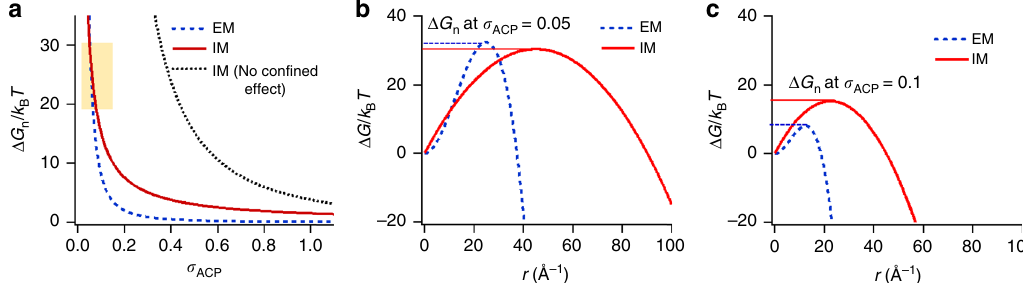
Fig. 4 Energy barriers to ACP nucleation at different σ ACP . a Δ G n for three different nucleation models: uncon fi ned nucleation without pAsp (representing extra fi brillar mineralization, EM), con fi ned nucleation with pAsp (representing intra fi brillar mineralization, IM), and uncon fi ned nucleation with pAsp (IM with no con fi ned effect). b , c Δ G pro fi les at σ ACP = 0.05 and 0.1 (yellow box in